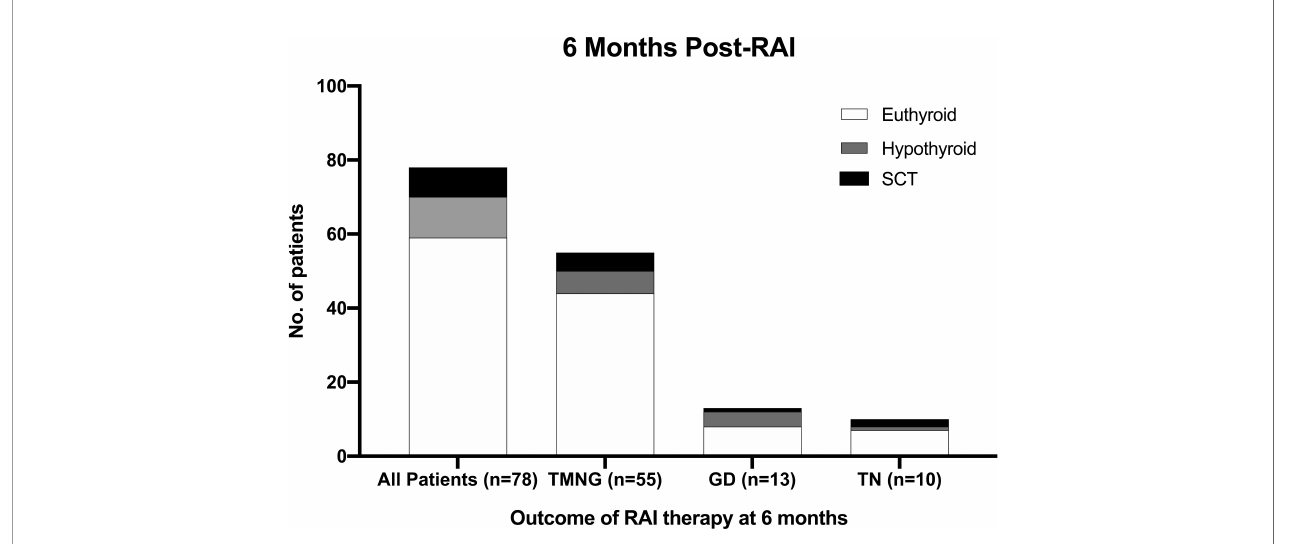
FIGURE 2 | Outcome for SCT patients 6-month post-RAI therapy.